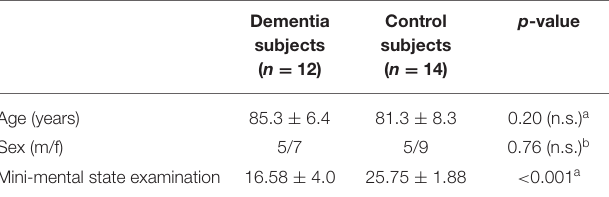
TABLE 1 | Demographic information and cognitive performance in dementia subjects and